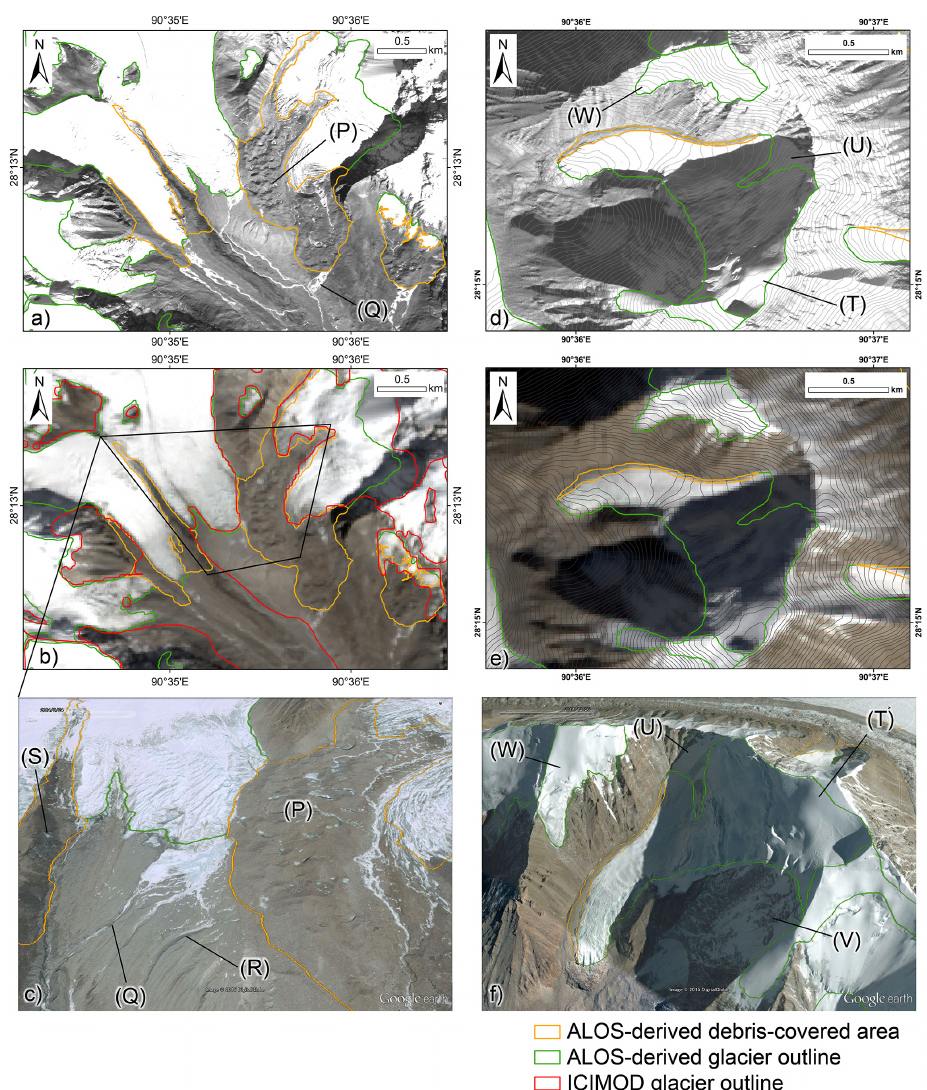
Figure 4. Complex surface features on the termini of debris-covered glaciers in our study site, shown in (a) ALOS PRISM imagery, (b) Landsat-8 imagery, and (c) Google Earth (location shown in Fig. 3). (P) Small ponds, ice cliffs, and bumpy surface relief, as well as (Q) traces of water stream, are recognised in (a) and (b) , whereas (R) bedrock and moraine surfaces are hard to identify in (b) . (S) Debris- covered ice is partly exposed and identified. Delineation of a glacier with steep surrounding slopes located in our study site, shown in (d) ALOS PRISM, (e) Landsat 8 imagery, and (f) Google Earth (location shown in Fig. 3). (T) Heavily snow-covered surface, on which ice flow is expected, is identified as part of the glacier, whereas the regions (U) and (V) are snow-covered areas with poor snow depth for accumulation that are excluded from the glacier because surface features suggest no ice accumulation on these surfaces. The isolated ice mass (W) is included as part of the glacier because its mass probably provides ice to the